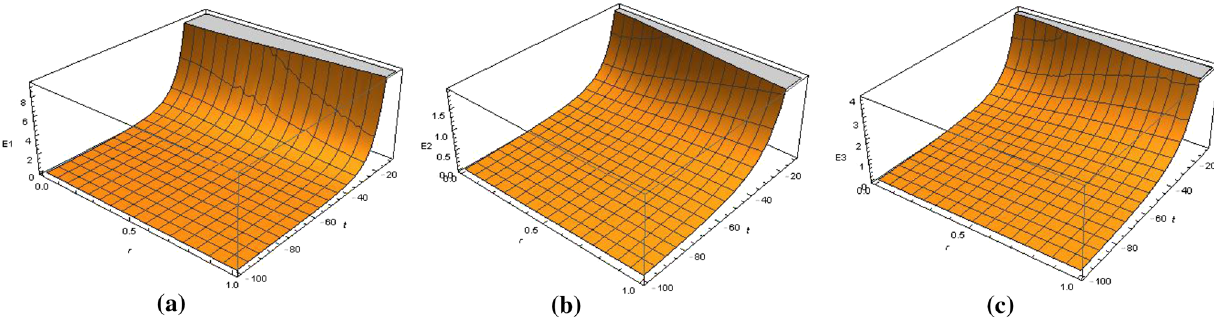
Fig. 4 a Plot of the energy condition E 1 with respect to t and r , b plot of the energy condition E 2 with respect to t and r , c plot of the energy condition E 3 with respect to t and